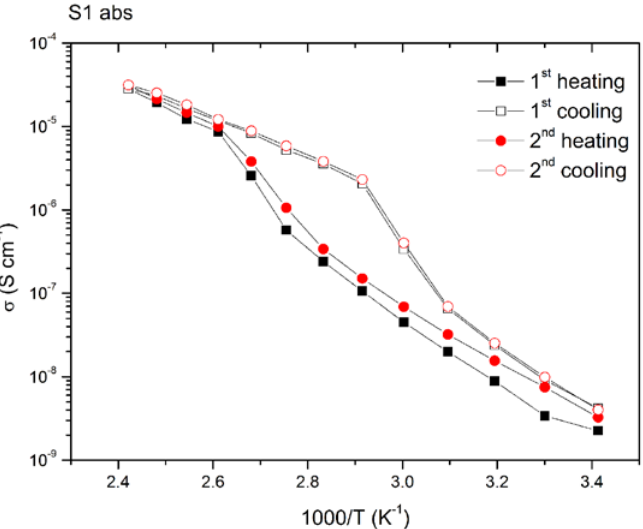
Figure 7. Li-ion conductivity measured by AC impedance spectroscopy for S1 abs. Conductivity was measured every 10 °C from RT to 140 °C and back down to RT. See text for further discussion.